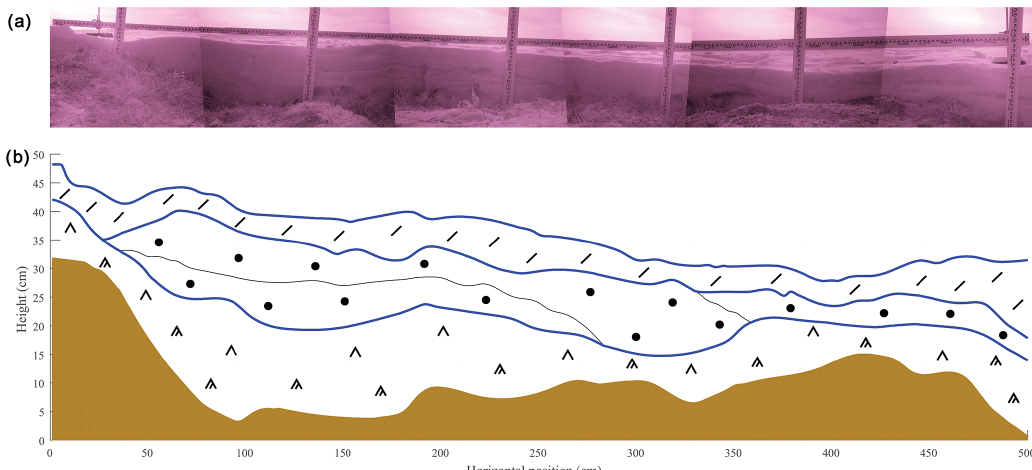
Figure 2. (a) Stitched NIR images of the trench face (trench 10). (b) Layer boundaries derived from NIR imagery; blue lines highlight boundaries between snow and air, surface snow and wind slab, and wind slab and depth hoar. The brown area is subnivean soil or vegetation. Symbols describe snow type following the classification by Fierz et al.